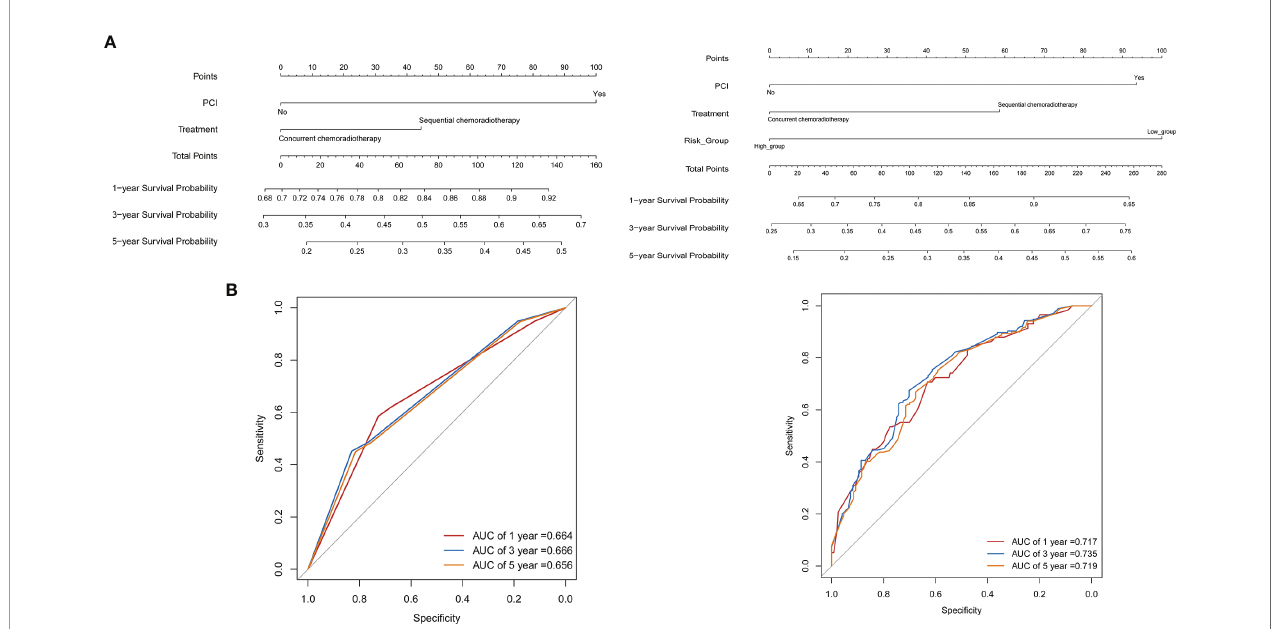
FIGURE 4 | Nomograms for predicting the 1-, 3-, 5-year survival probability in limited-stage small cell lung cancer patients. (A) Nomograms locate each patient ’ s value on each variable axis, draw a line straight upward to the “ Point ” axis to determine the number of points received for each variable value, sum the scores achieved for each covariate, and locate the gross score on the “ Total Points, ” then delineate a line straight down to determine the probability of 1-, 3-, 5-year survival. (B) The receiver operating characteristic (ROC) curve analyses revealed the accuracy of prognosis in two nomogram